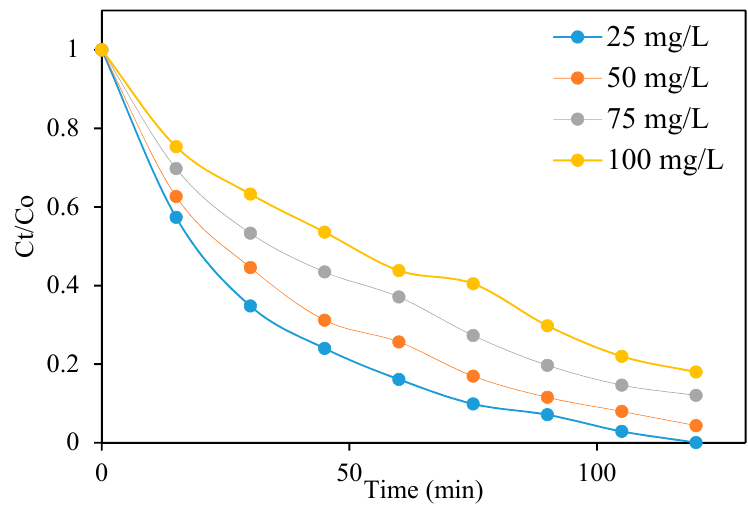
Figure 8. Effect of TC concentration on Cu 7 S 4 (250 °C) (dosage: 80 mg, irradiation time: 120 min, pH: 4).